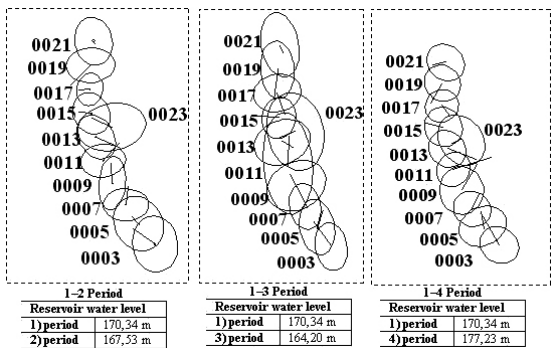
Fig. 4. The deformation elipses drawing between